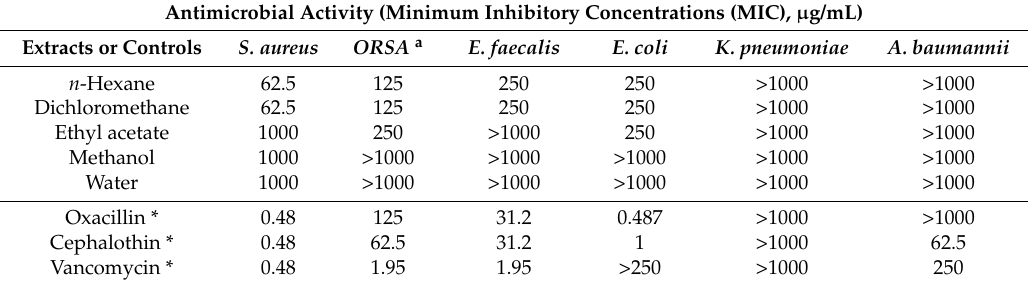
Table 1. In vitro antimicrobial activity of extracts from aerial parts of S. pachyphylla . Antimicrobial Activity ( minimum inhibitory concentrations ( MIC), μ g/mL) Extracts or Controls